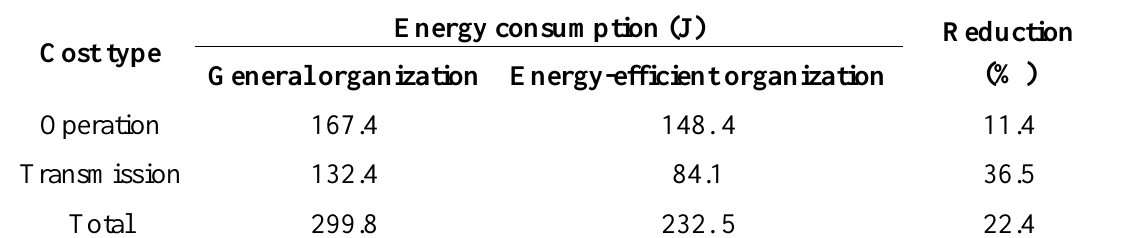
Table 3. Energy consumption comparison of general and energy-efficient organization.